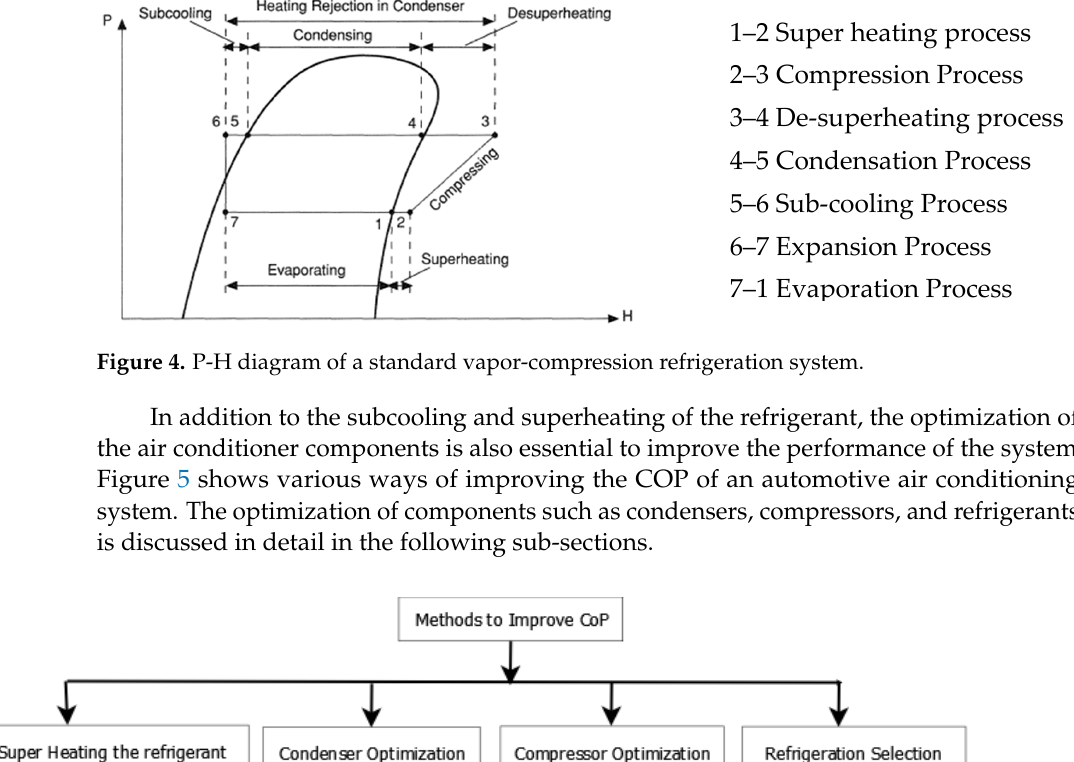
Figure 5. Various ways of improving the COP of an automotive air conditioning system.